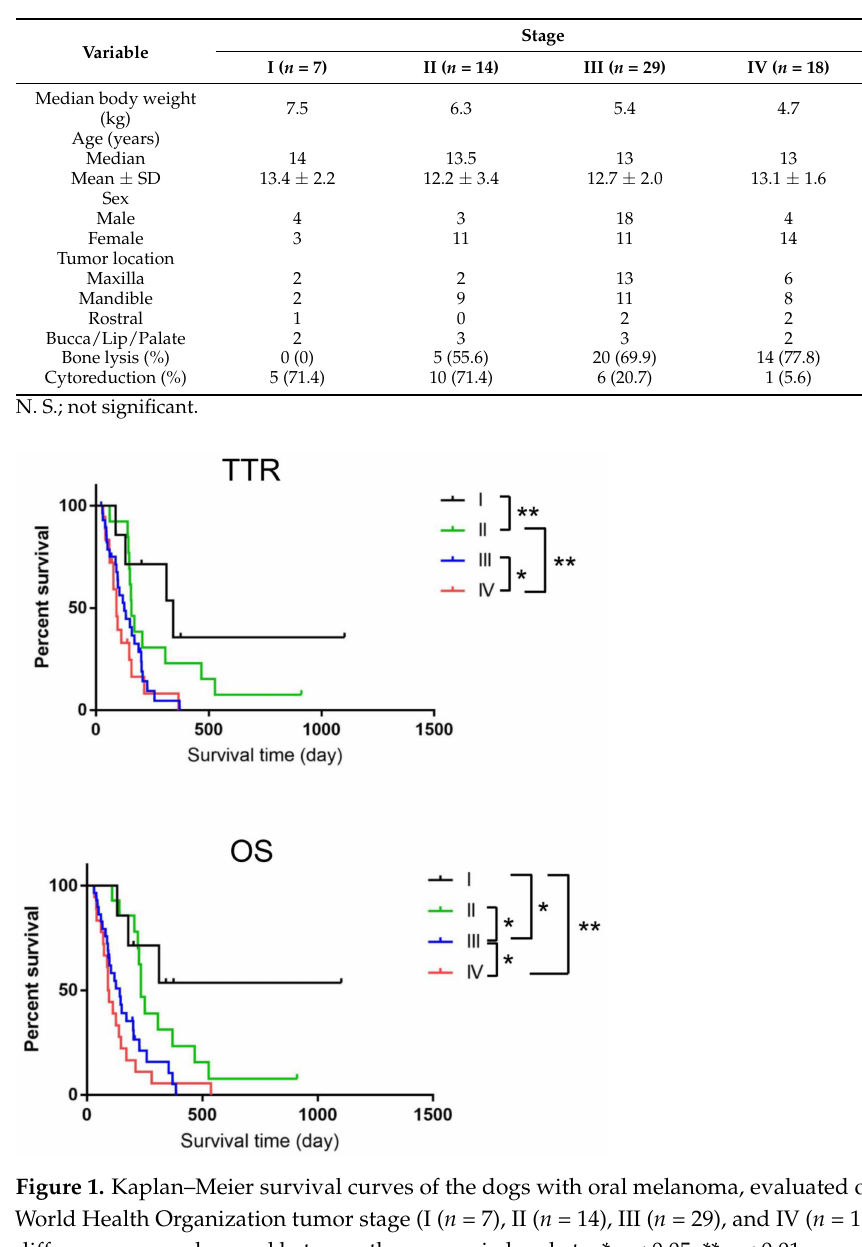
Table 1. Demographic characteristics, anatomic location of oral melanomas, and existence of bone lysis in the oral melanomas of the 68 dogs.